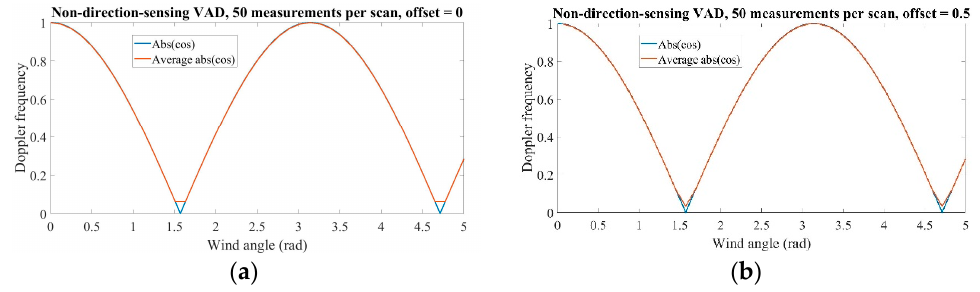
Figure 12. As for Figure 11, with 50 contiguous segments per scan rotation. The bias is now negligible. ( a ) The true wind heading coincides with the midpoint angle of a segment (i.e., zero offset); ( b ) The true wind angle coincides with the edge of a segment (i.e., offset = 0.5 segment).